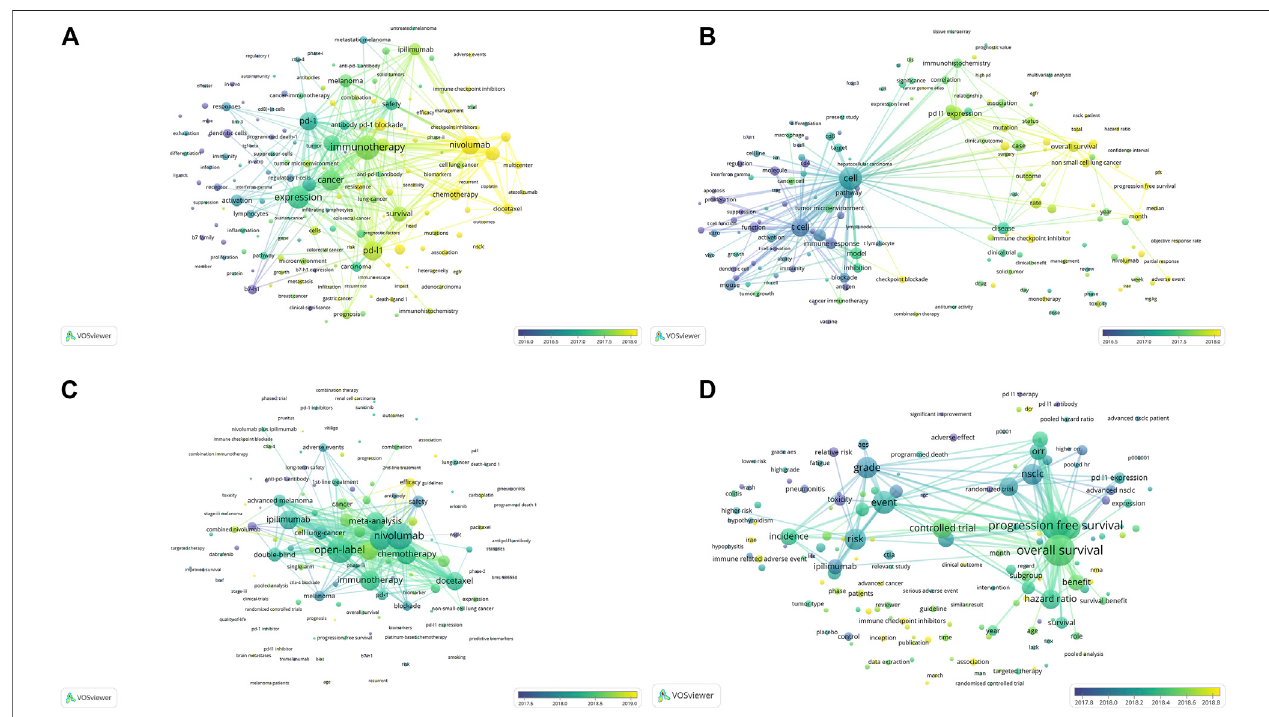
FIGURE7| Theoverlayvisualizationmapofkeywordandtermco-occurrenceanalyses.Keywordco-occurrenceoverlay (A) andtermco-occurrenceoverlay (B) in the articles on the PD1/PDL1 molecule. Keyword co-occurrence overlay (C) and term co-occurrence overlay (D) in meta-analysis of anti-PD1/PDL1.